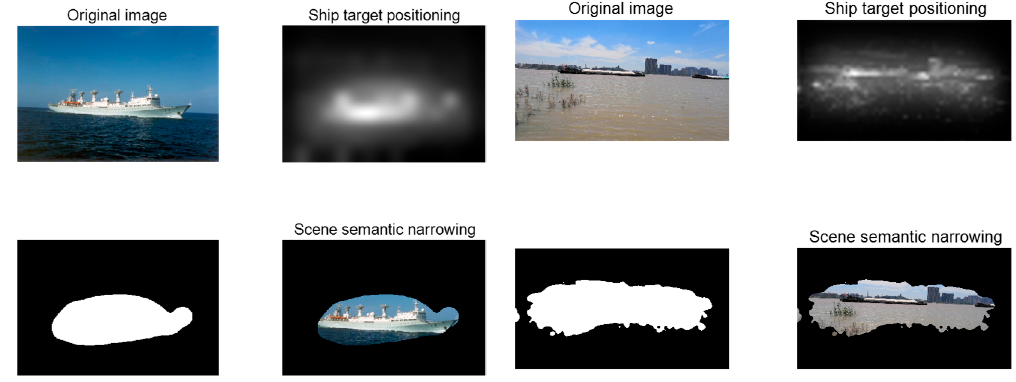
Figure 5. Scene Semantic Narrowing result graph.